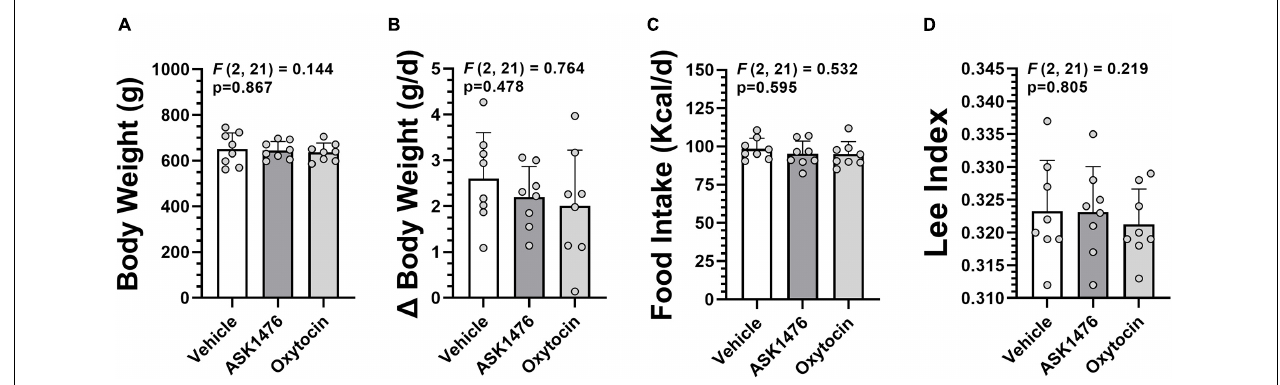
FIGURE 2 | Baseline data used for group assignment in the long-term (28-day) vehicle vs. ASK1476 vs. OXT experiment. Groups were well matched with no difference in body weight at start of treatment (A) , average daily body weight change during 7-day baseline phase (B) , and average daily food intake during 7-day baseline phase (C) . Additionally, Lee Index at start of treatment was used as an indicator of adiposity (D) .